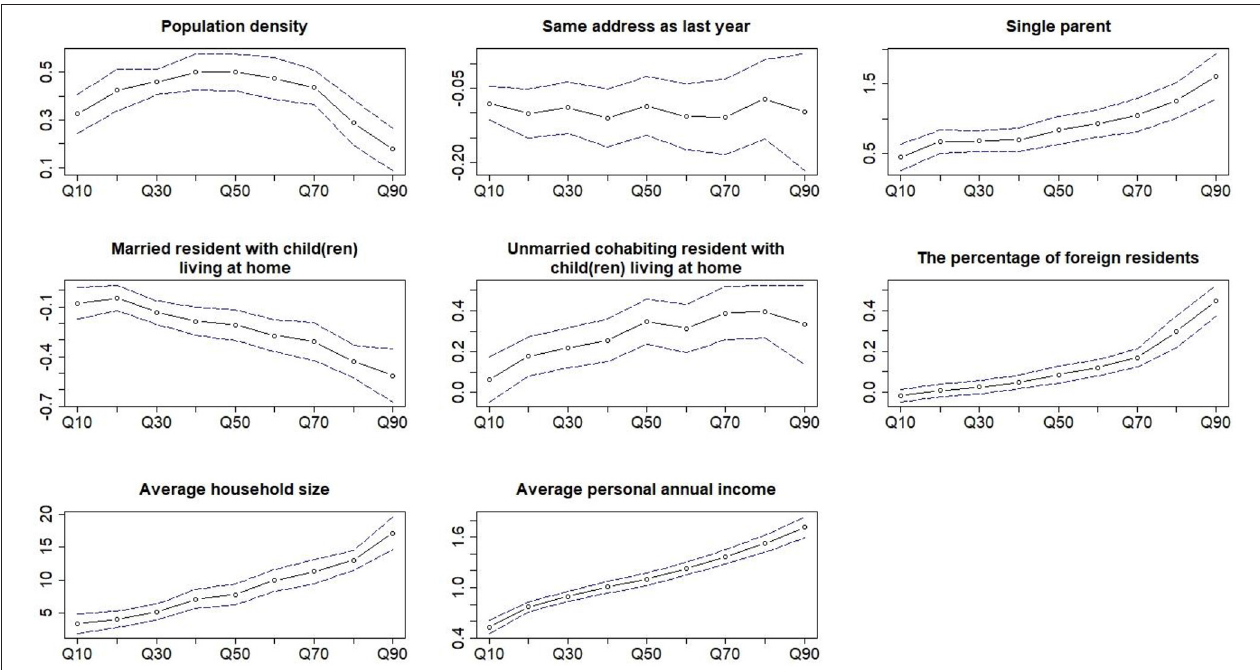
FIGURE 2 | Coefficients of the multivariable quantile regression of all the covariates as a function of the different quantiles of the coverage of the opportunistic screening. The dotted line and the blue dash lines are the coefficient and the 95% CI of quantile regression at the different quantiles of the outcome.